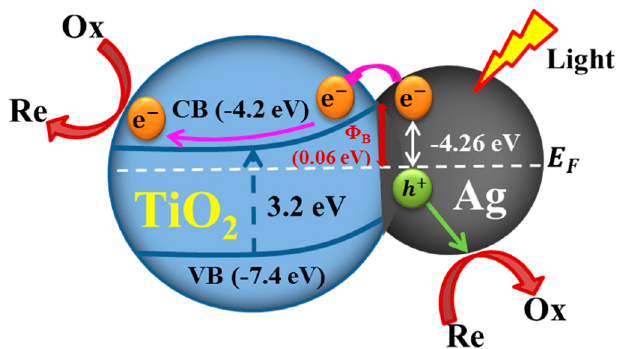
Figure 7. Schematic band energy diagram of charge transfer at the Ag NW/TiO 2 NP interface (not drawn to scale). CB and VB indicate the conduction band and valence band of anatase TiO 2 . E F presents the Fermi level of Ag. Φ B is the Schottky barrier height.